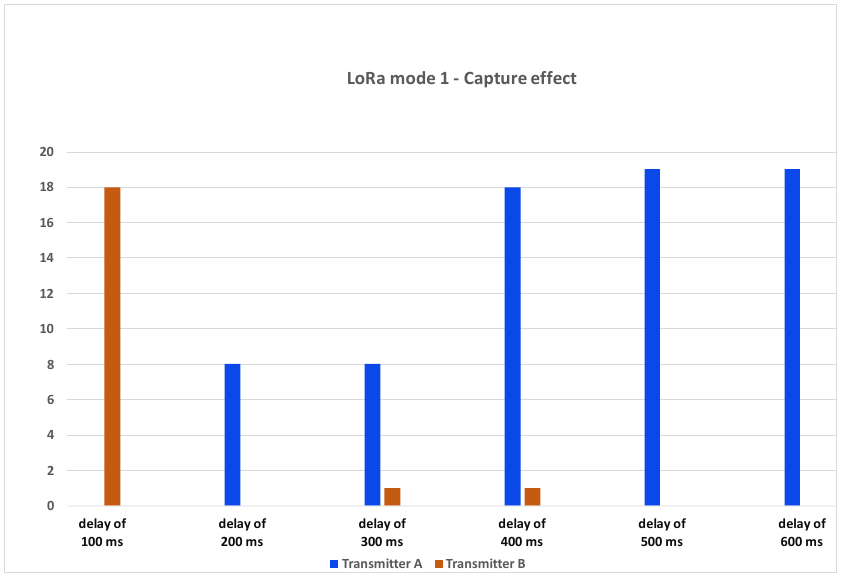
Figure 7. Capture effect test results.